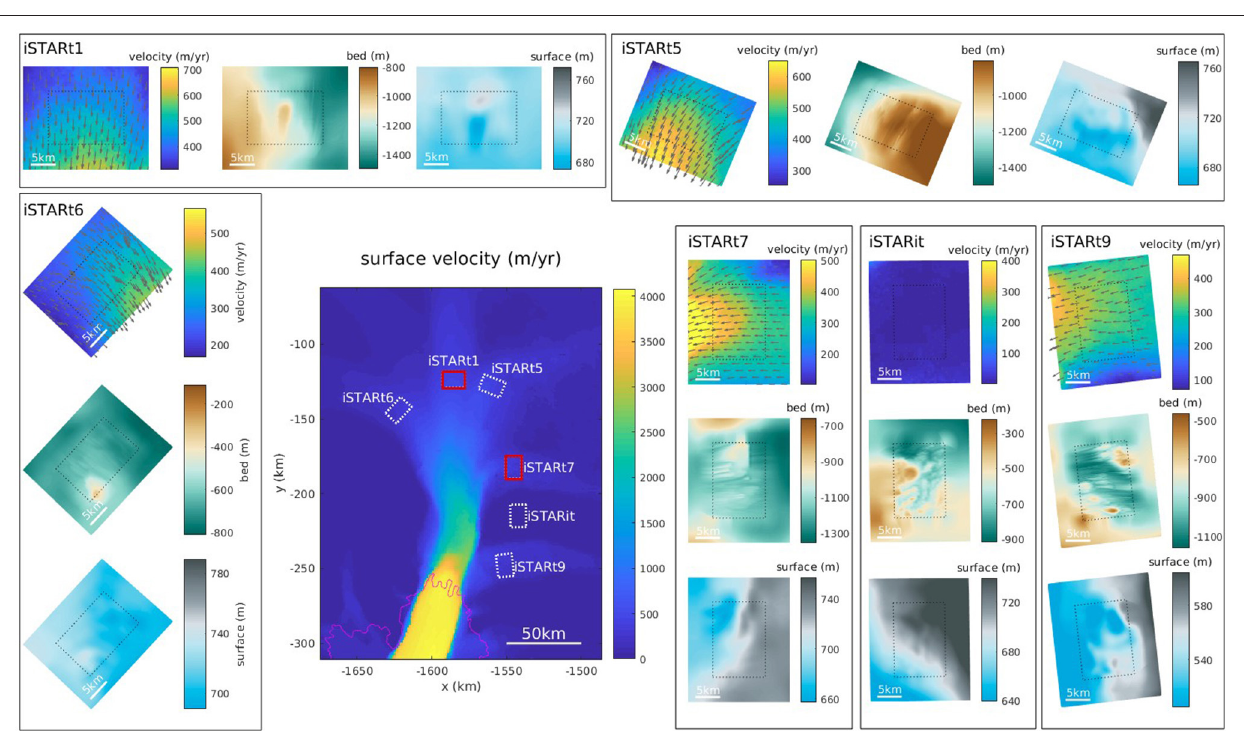
locations. The largest differences in values are found in regions where the most noticeable smoothing has occurred e.g., around the margins of the ice